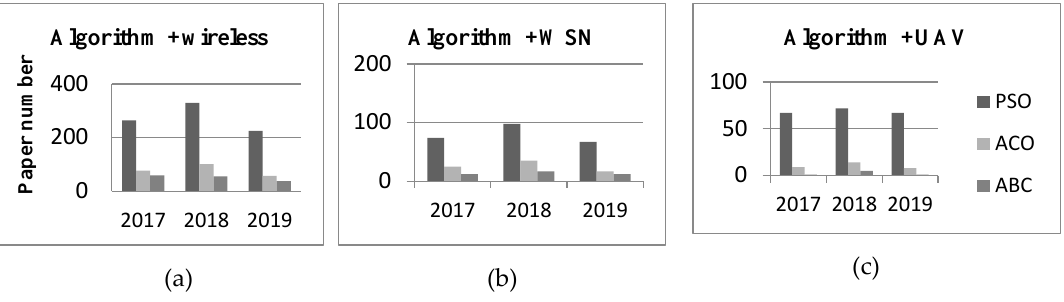
Figure 7. Numbers of SI literatures about wireless, WSN and UAV in Scopus (by October, 2019).